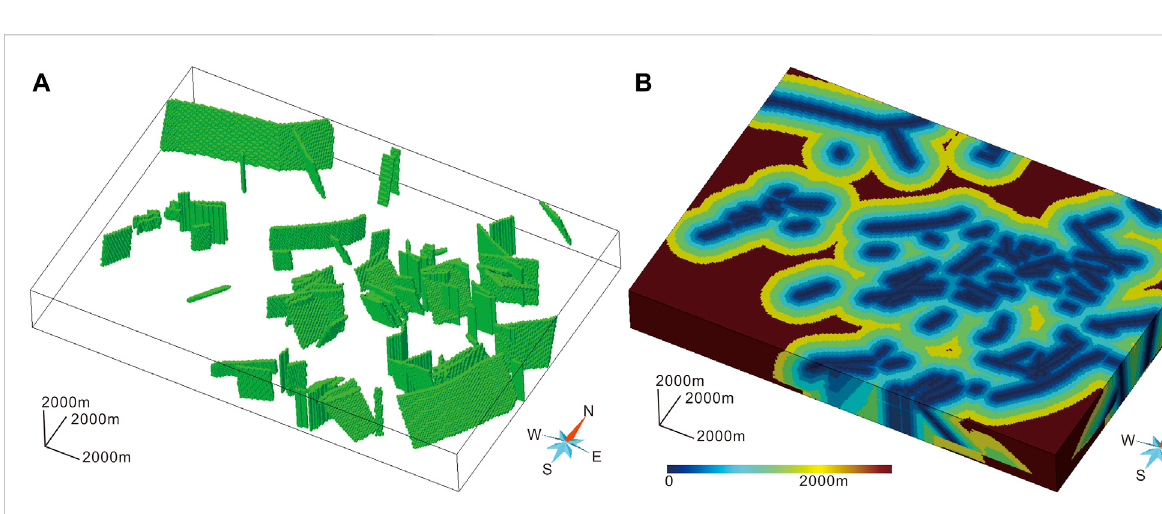
FIGURE 7 Secondary fault model of (A) the 3D secondary fault solid model (B) the 3D secondary fault buffer